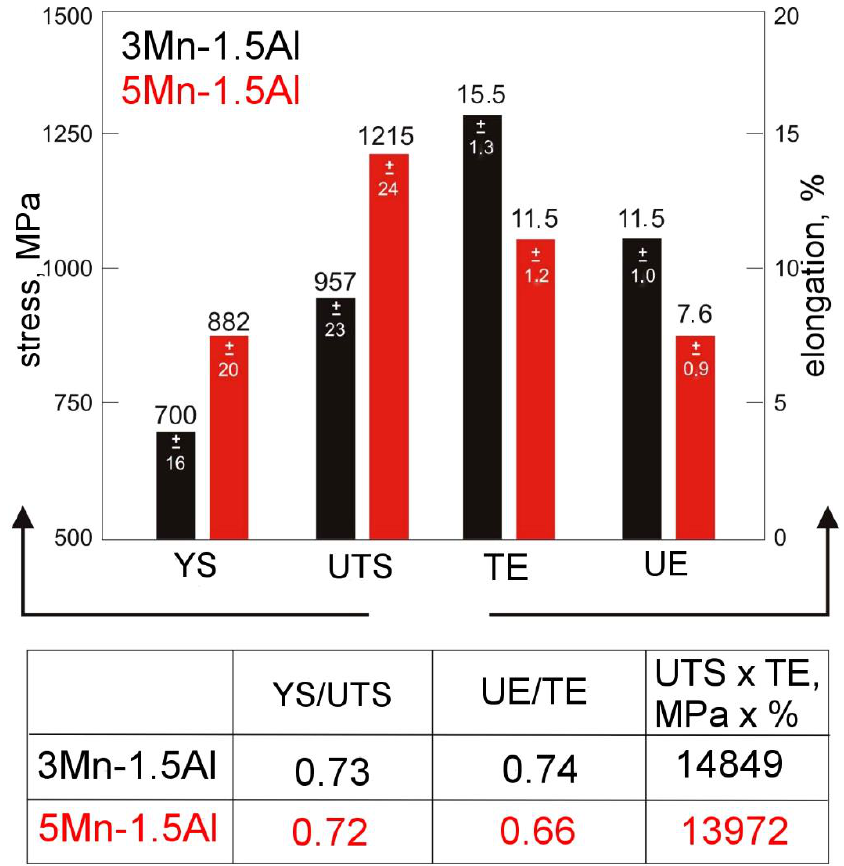
Figure 6. Mechanical properties of investigated steels determined in static tensile tests.